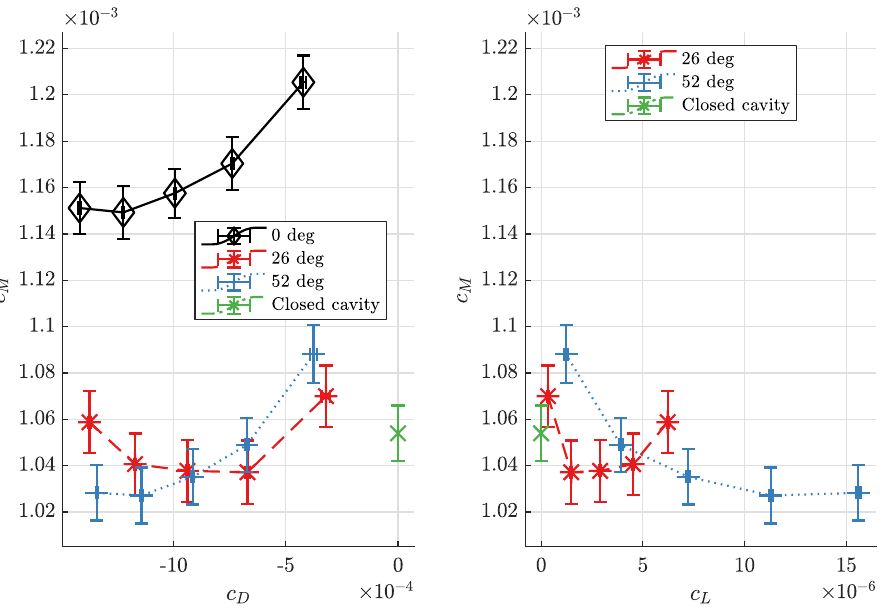
Figure 7. Torque coefficients c M measured at the relative gap width of G = 0.0375 and in the Reynolds number range of 7.5 10 7 9.6 10 7 : The closed cavity configuration is compared to centripetal Re × ≤ ≤ × through-flow at three different preswirl angles.